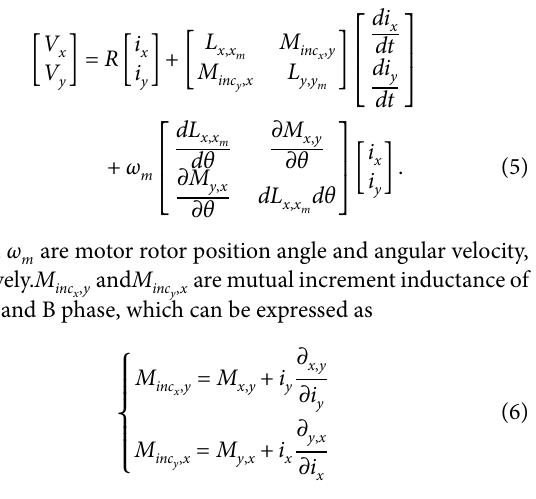
FIGURE 2 | Inductance curve of three-phase 12/8 pole SRM. (A) Self-inductance curve profile. (B) Mutual inductance.